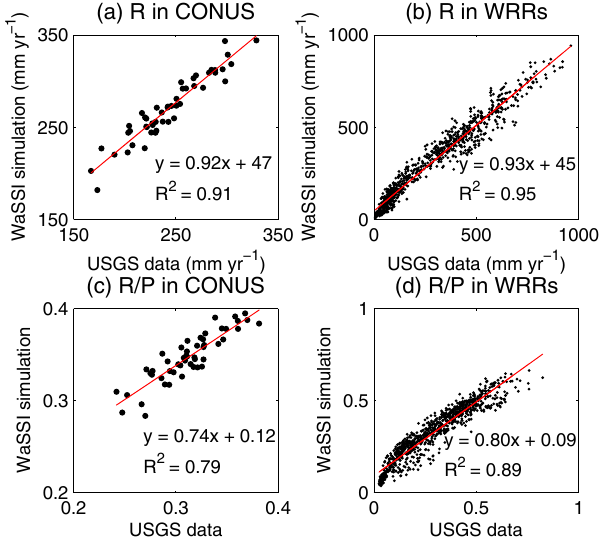
Figure 2. Validations of the WaSSI model at the conterminous United States (CONUS) and water resource region (WRR) lev- els. (a, b) Comparisons of simulated annual runoff ( R ) (mmyr − 1 ) against USGS observed data in 1961–2010 over the entire CONUS (a) and in 18 WRRs (b) . (c, d) Comparisons of simulated runoff coefficient (runoff / precipitation, R/P ) against that derived from USGS observed data in the CONUS (c) and WRRs (d)